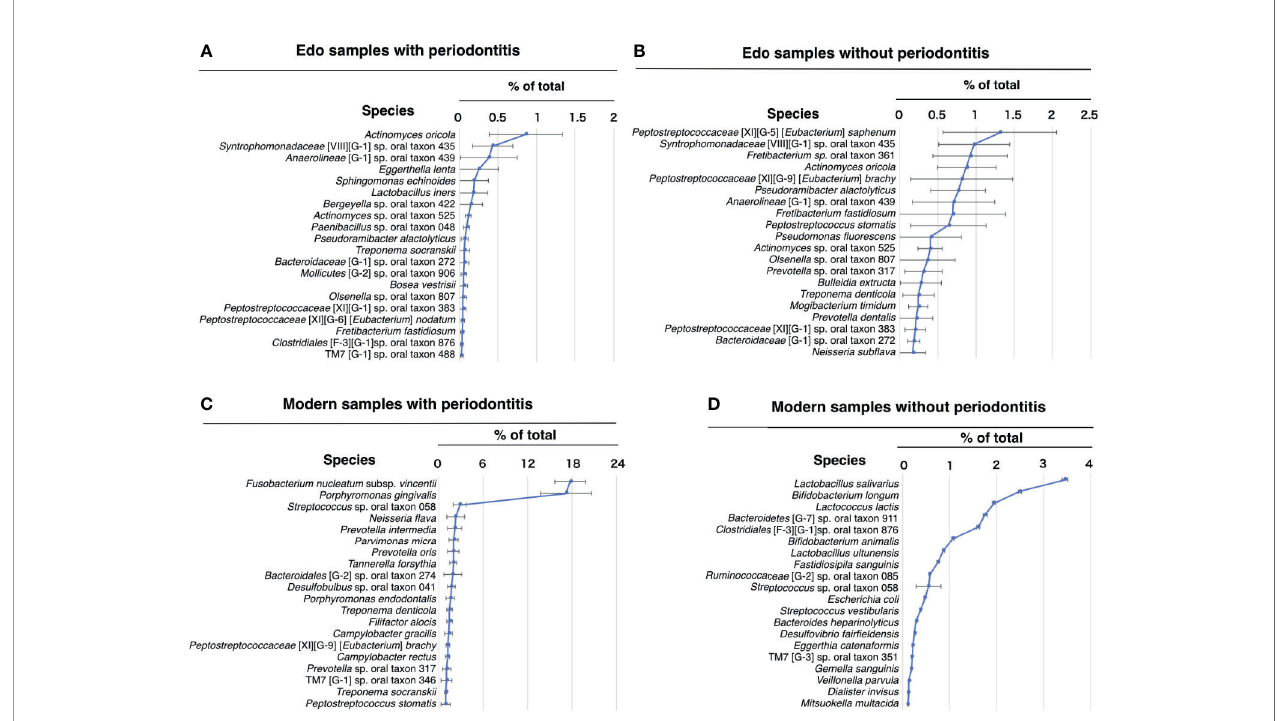
FIGURE 6 | Percentage compositions according to species. (A) Edo sample with periodontitis, (B) Edo sample without periodontitis, (C) modern samples with periodontitis, and (D) modern sample without periodontitis. The bars show mean ± SE relative